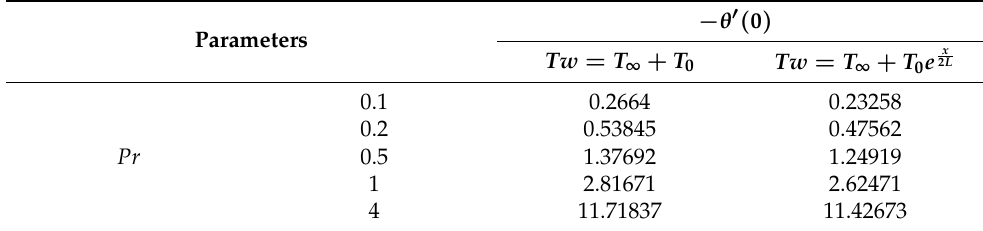
Figure 14. Influence of Pr on − θ (cid:48) ( 0 ) obtained by HAM with M = s = γ = 3. Table 2. Analytic approximations (HAM) of − θ (cid:48) ( 0 ) under different wall temperature conditions for various Pr with M = γ = s =